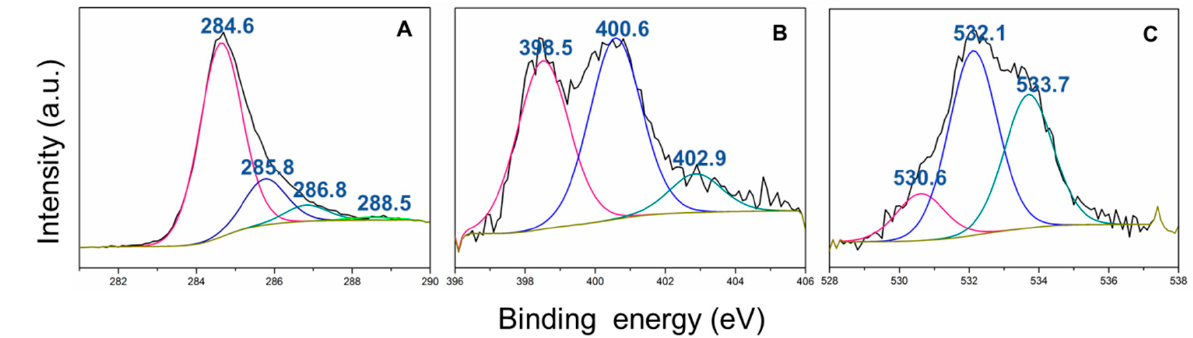
Figure 7. The deconvoluted XPS spectra of ( A ) the C1s, ( B ) N1s, and ( C ) O1s signal of NC-750. To evaluate the water purification capacity of NCs, the rhodamine B (RhB) was chosen as the model contaminant, and its aqueous solution was treated with CNs of different types and amounts. The levels of residual RhB in the solution were then determined by measuring the absorbance of the treated RhB solution. The maximum absorbance was observed at 554 nm (Figure 8A), which is proportional to the concentration of the remaining RhB in the solution. The RhB solution after the NC-750 treatment showed the lowest peak